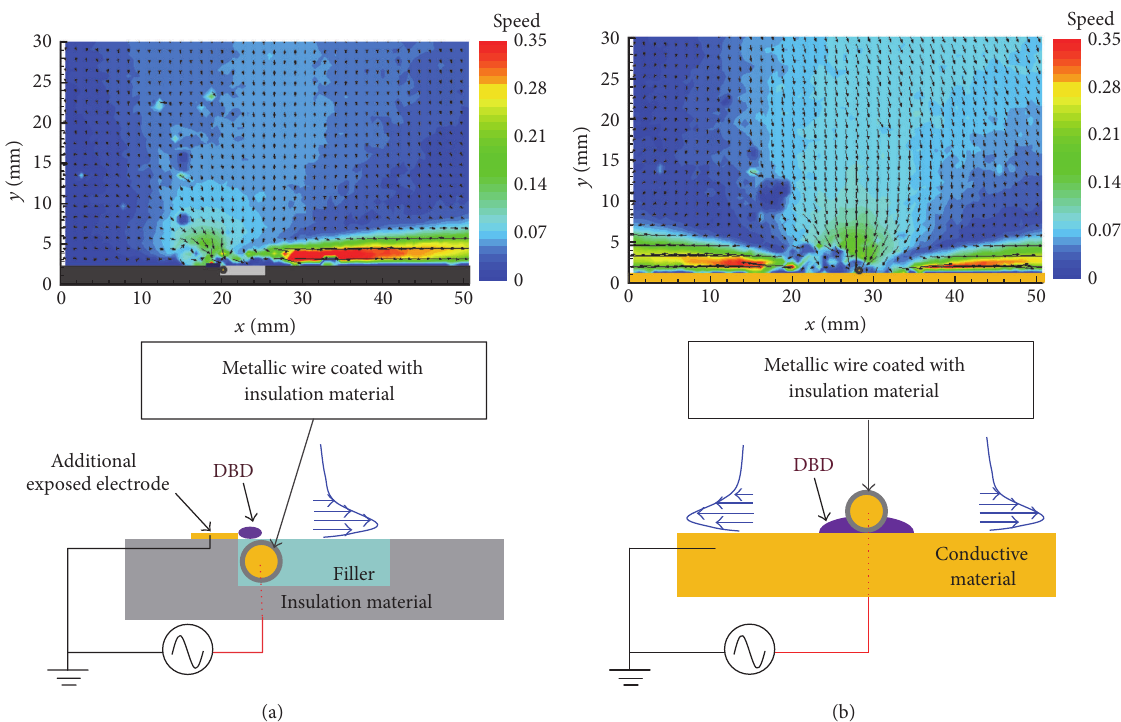
Figure 2: Basic structures and velocity distributions of string-type DBD plasma actuator designed by Segawa et al. [19]. (a) One-directional tangential jet is induced by embedding a metallic wire coated with insulation materials in insulation material. (b) The surface itself can be chosen as the exposed electrode when the wire is attached on surface of conductive material.